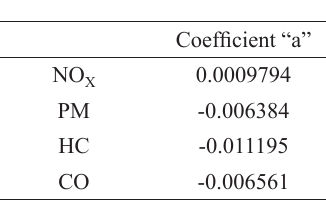
Values of coeffi cient "a".